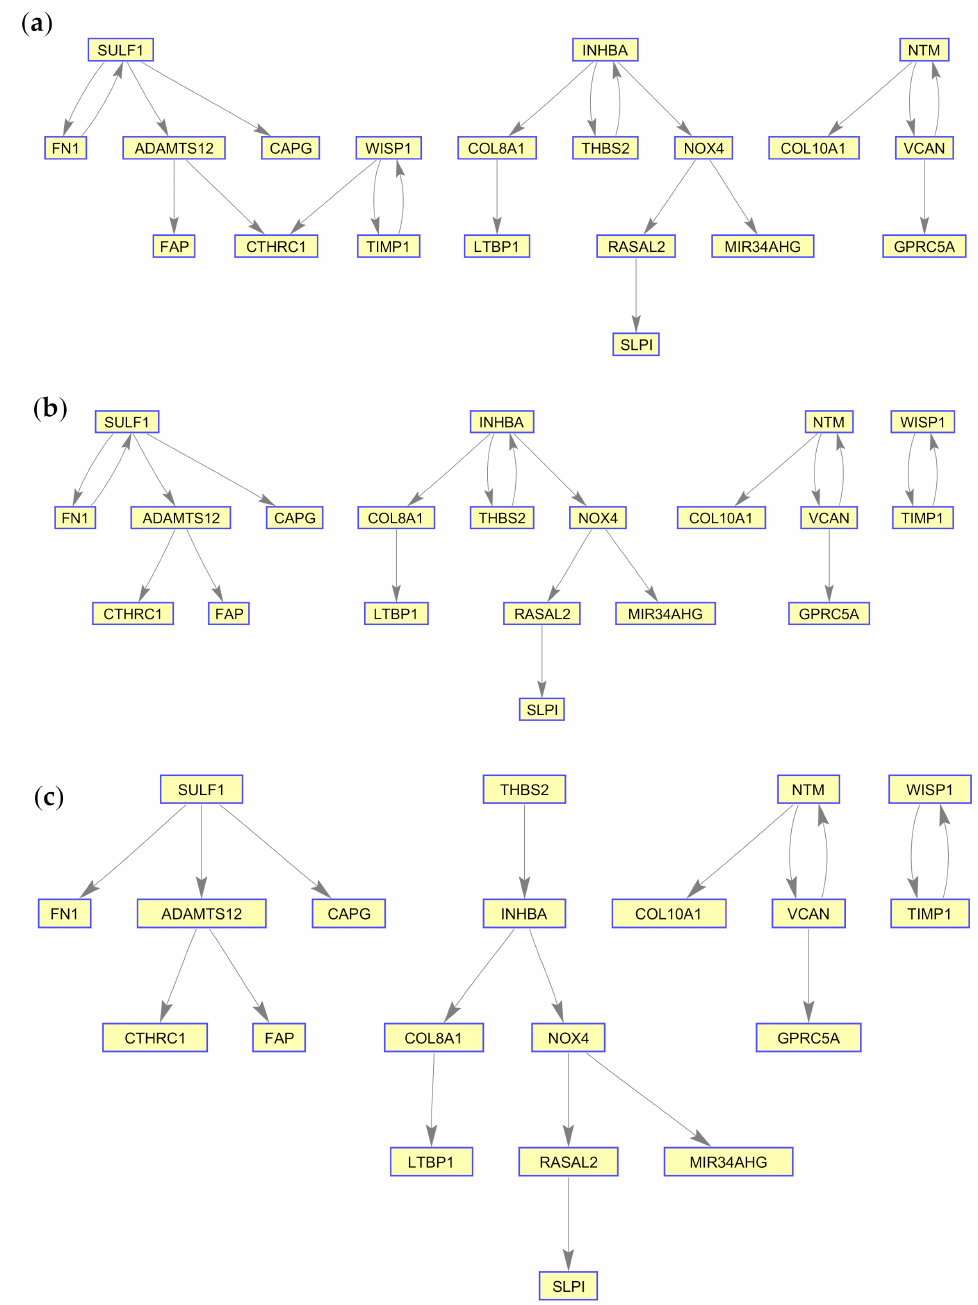
Figure 6. GRNs generated from the application of MIDER on the PDAC dataset. ( a ) GRN with all edges selected (no threshold); ( b ) GRN with selected edges (Using 95% threshold); ( c ) GRN with selected edges (Combining output of